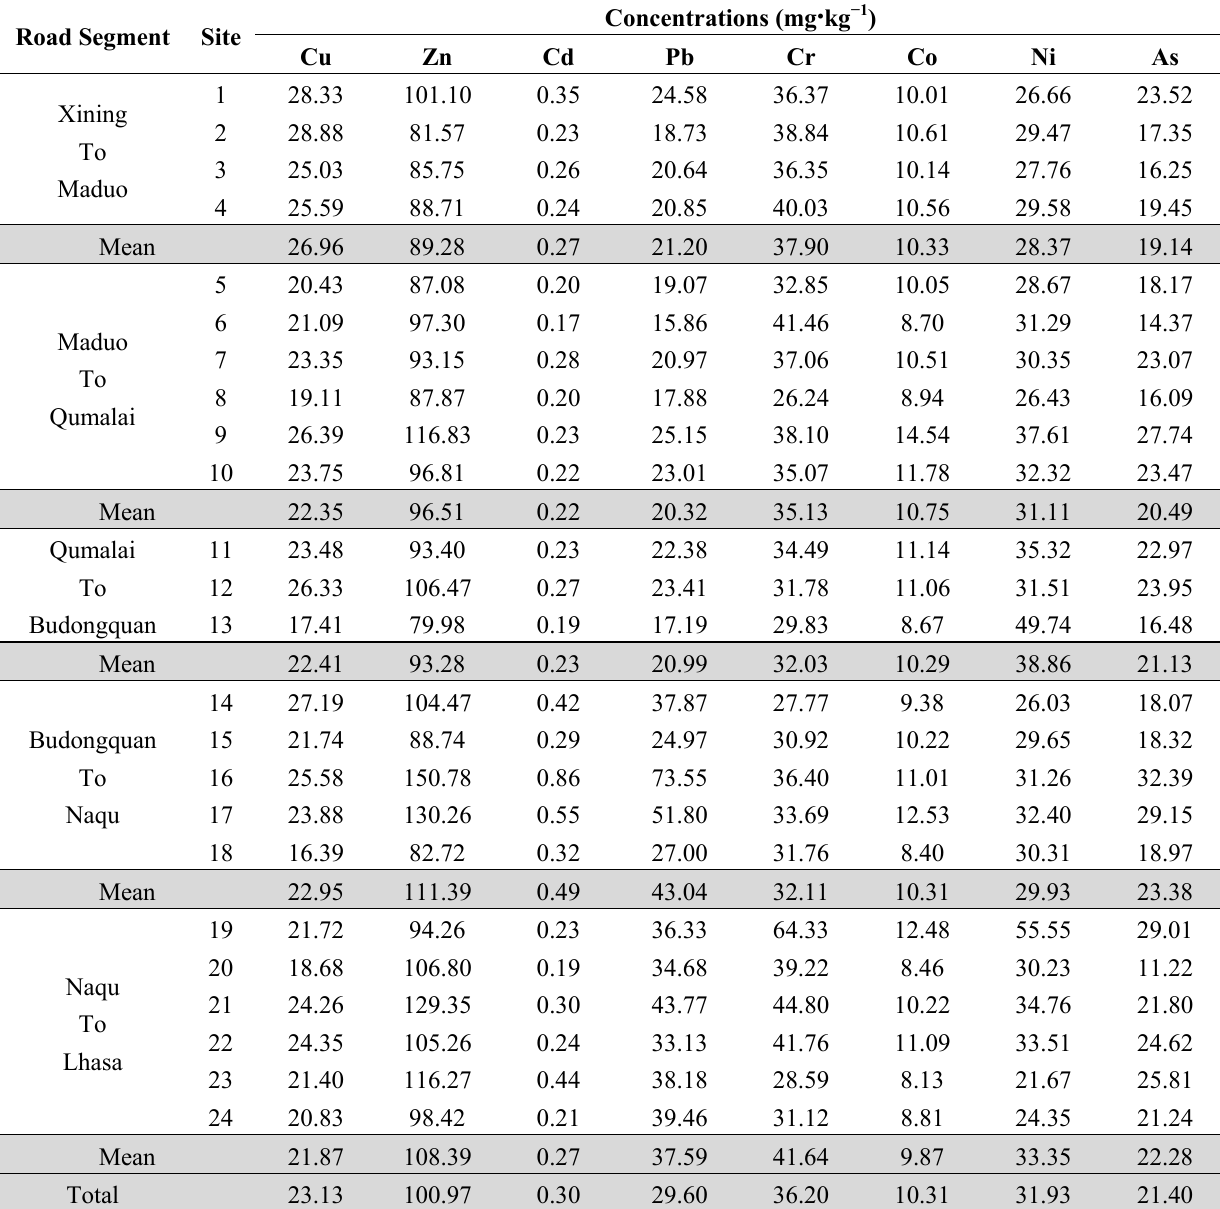
Table 2. Concentrations of roadside soil heavy metals on different road segments. Road